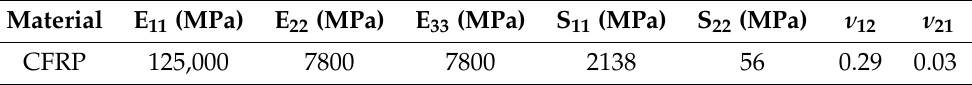
Table 1. Material properties of the carbon-fiber-reinforced polymer (CFRP) plates [22].